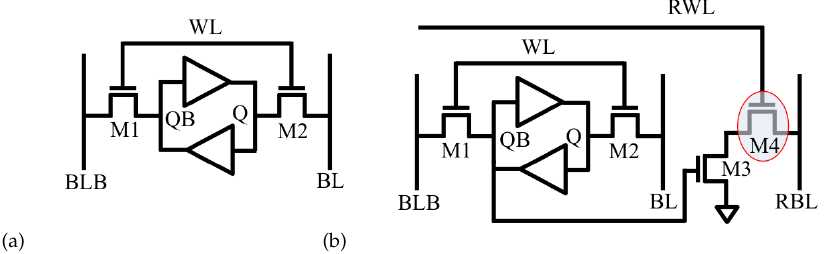
Figure 1. Conventional static random access memory (SRAM) structures. ( a ) 6T and ( b )